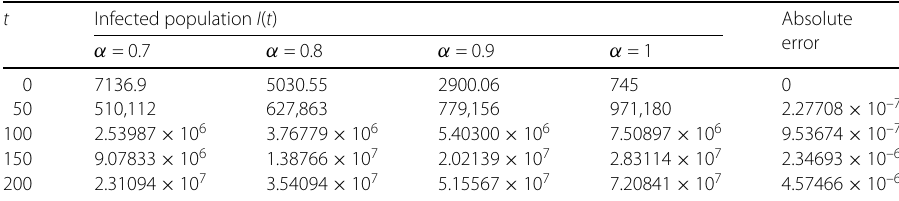
Table 4 Numerical results of infectious population I ( t ) for fractional parameter τ = 0.7,0.8,0.9,1 and comparison between classical and approximate solution